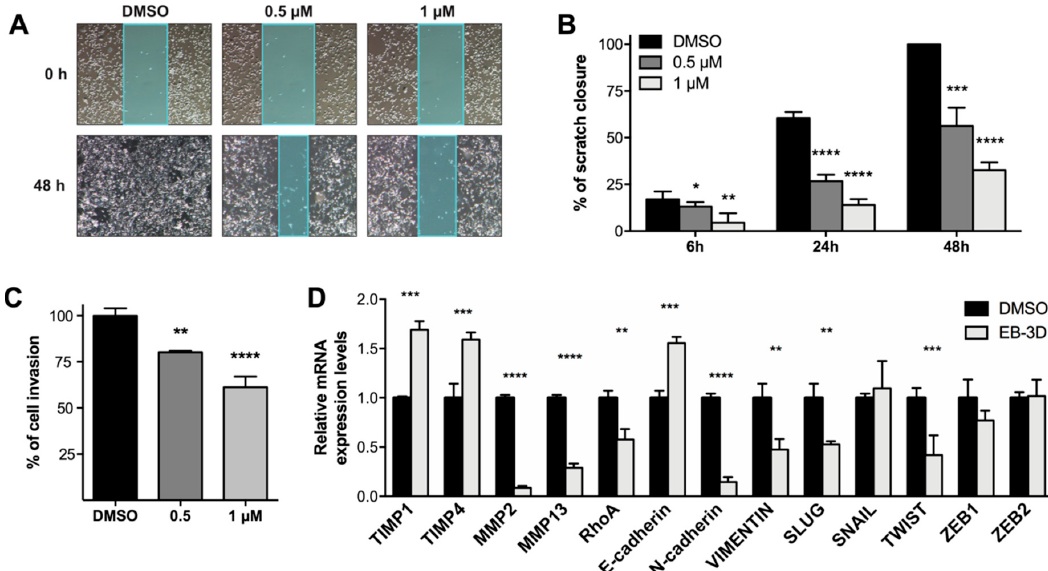
Figure 4. EB-3D impairs MDA-MB-231 motility and invasiveness. ( A ) Representative images